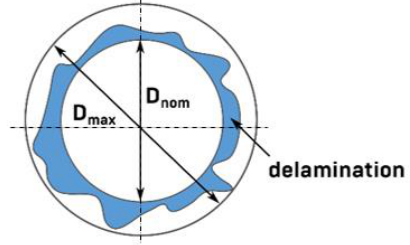
Figure 7. Delamination factor scheme.